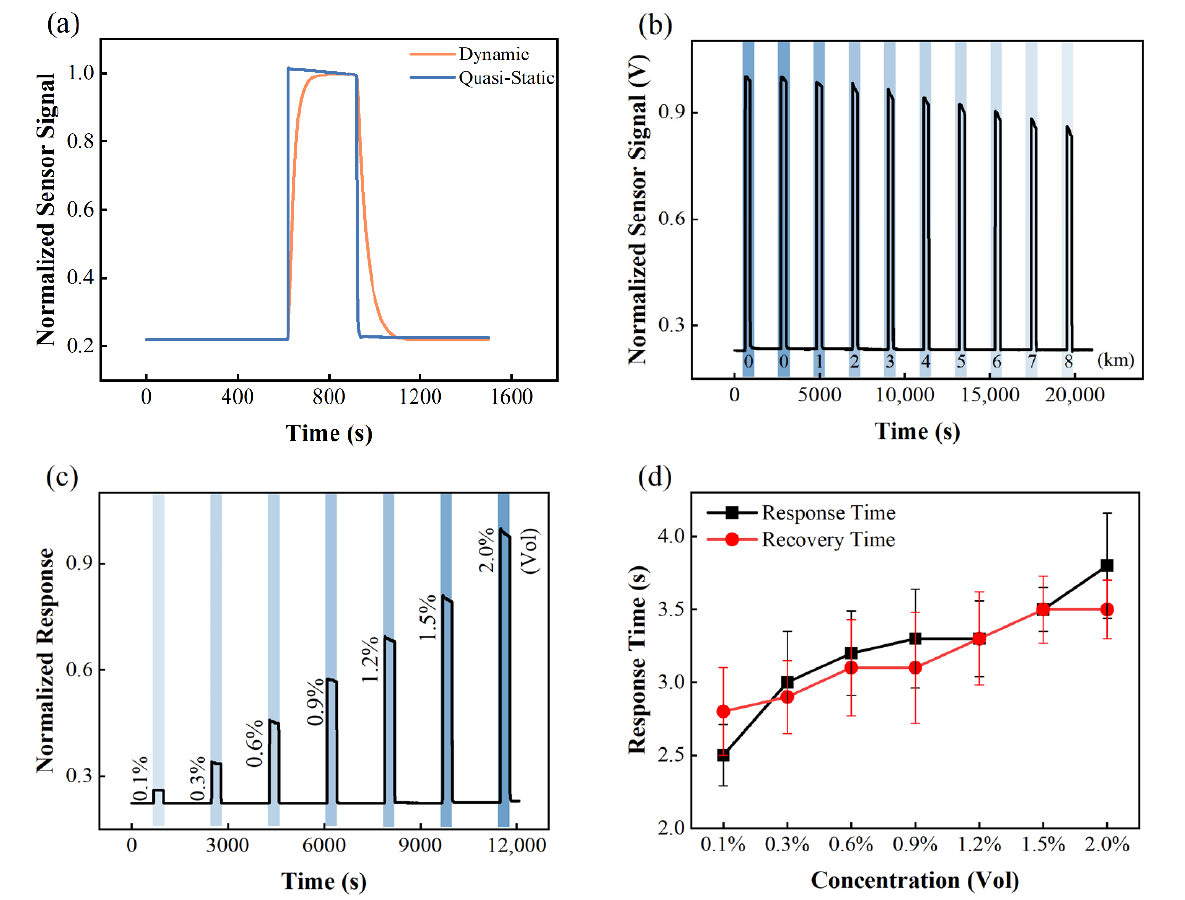
Figure 4. ( a ) Hydrogen sensor responses for conventional dynamic mode and vacuum-assisted quasi-static mode; ( b ) hydrogen sensor responses recorded at different ambient pressures, where hydrogen concentration in air is maintained at 2%; ( c ) hydrogen sensor responses recorded at different hydrogen concentration; ( d ) the response and recovery times plotted as functions of hydrogen partial pressure. The sensor used in this measurement is a commercialized catalytic combustion sensor. The working temperature is 250 °C and the applied voltage is 12 V.